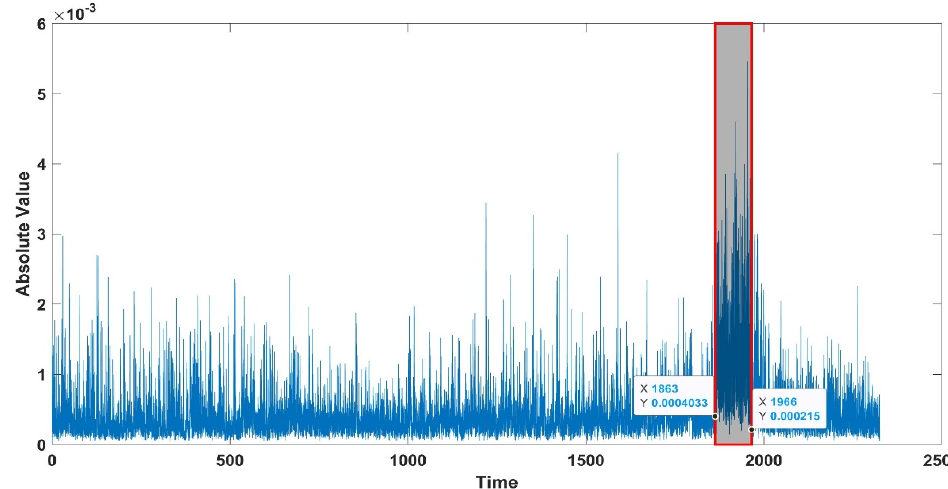
Figure 6. Feature showing the onset of seizure marked in the output window for chb01_26, using the proposed seizure-detection algorithm.